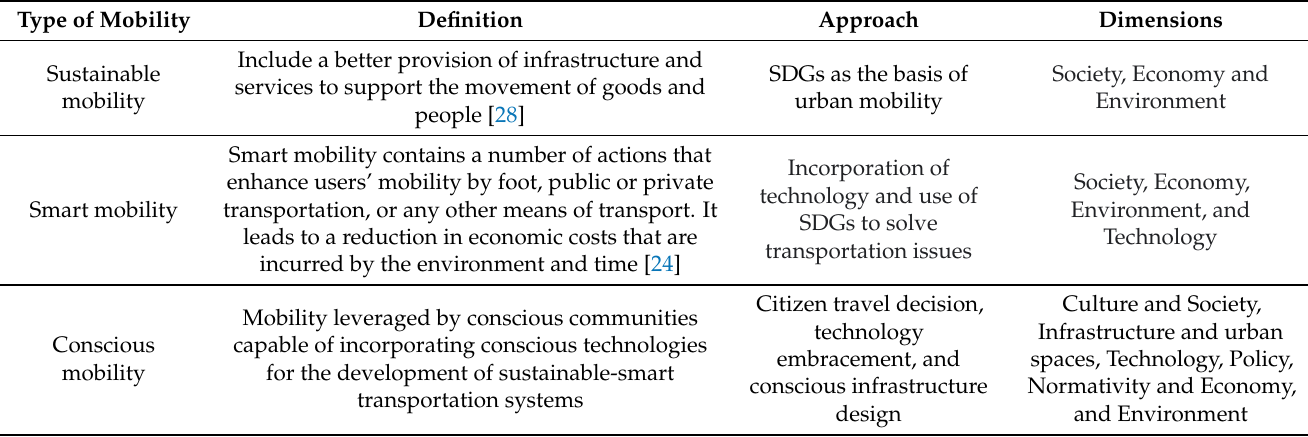
Table 1. Mobility strategies